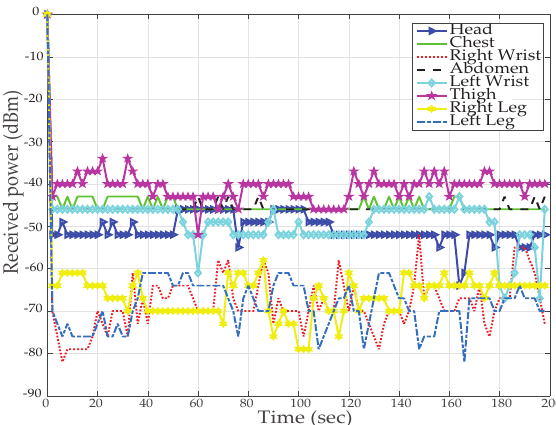
Figure 19. RX power using proposed dynamic control algorithm while sitting